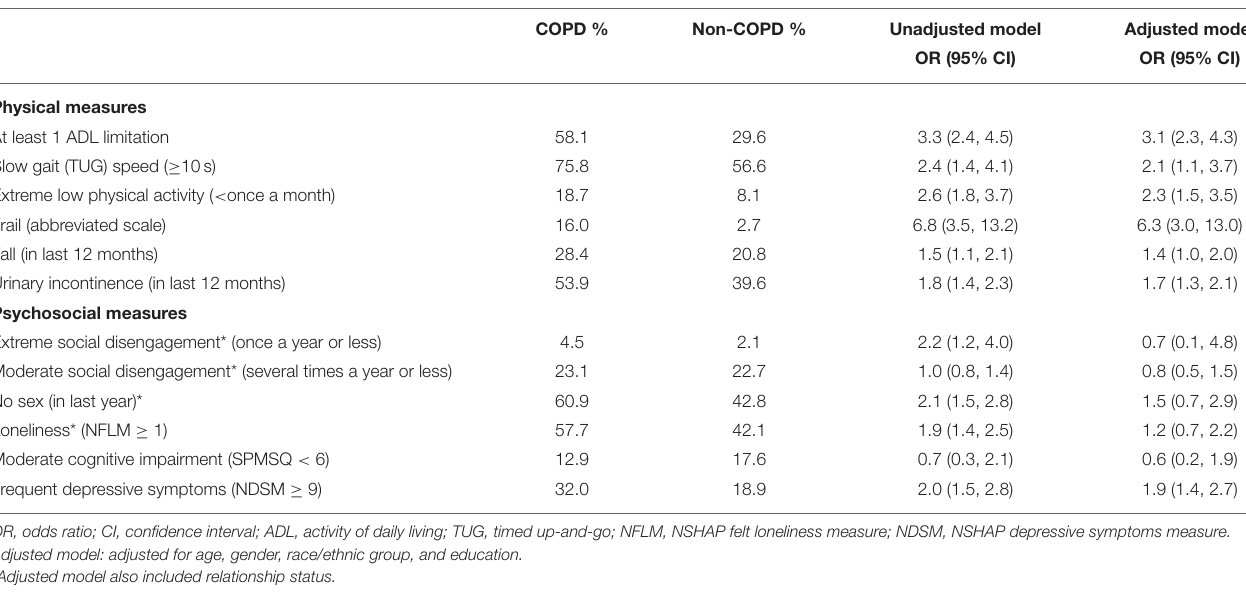
TABLE 3 | Unadjusted and adjusted multivariate logistic regression models comparing the prevalence of geriatric conditions among US older adults with and without COPD by self-report.